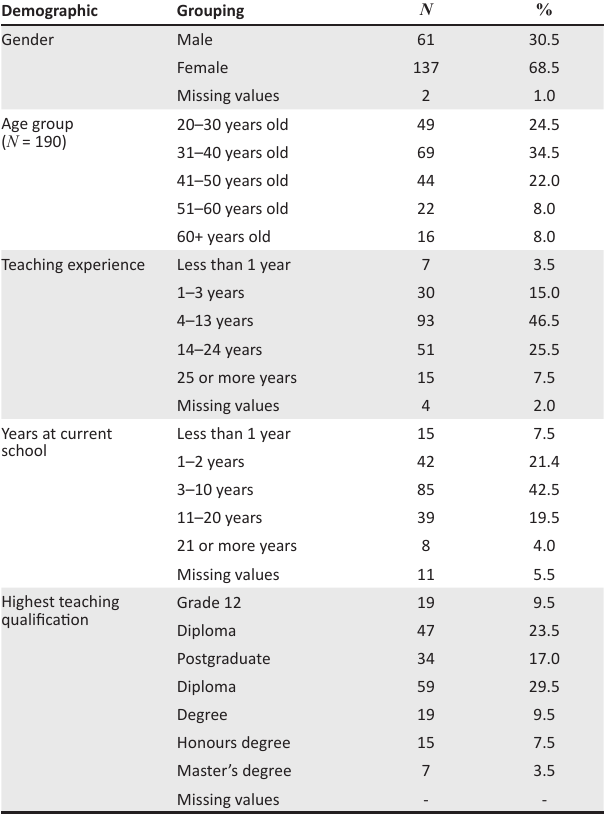
TABLE 1: Characteristics of participants ( N = 200).